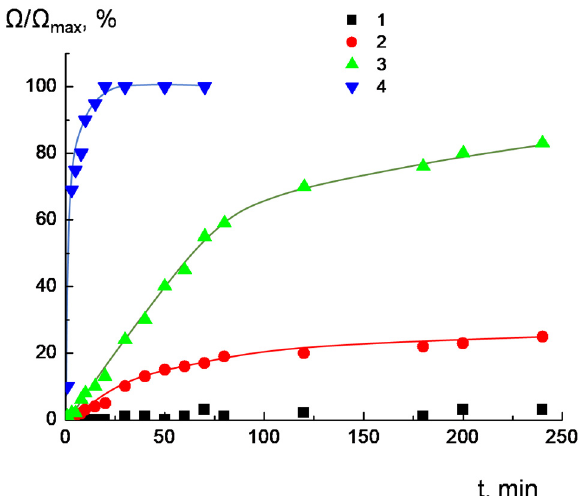
Figure 5. Time-dependent changes in relative conductivity of dendrimer–NaCl-loaded liposome complexes for D 350+ (1), D 229+ (2), D 215+ (3), and D 16+ (4). The ratio of the ionic groups was [+]/[ − ] = 2. CL/Chol/DOPC liposomes, [CL] = 1.5 × 10 − 4 mol/L, total lipid concentration of 1 mg/mL. 10 − 3 M phosphate buffer, pH 7.2.